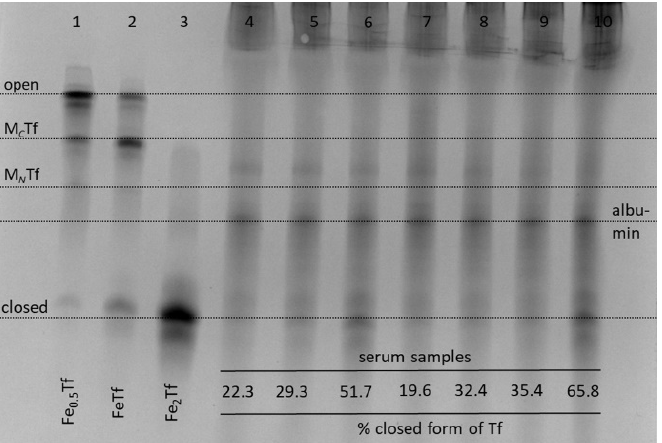
Figure 6. Typical urea-PAGE results for albumin-depleted human serum samples in the presence or absence of metal complexes: lane 4, no metals added; lane 5, Fe(III)-citrate; lane 6, Fe(III)-NTA; lane 7, Cp 2 TiCl 2 ; lane 8, VOSO 4 · 5H 2 O; lane 9, Na 3 VO 4 ; lane 10, In(III)-citrate. Whole serum was incubated with 50 μM of metal complexes for 4 h at 310 K, followed by the removal of excess albumin with Affi-Gel Blue columns (see Materials and Methods). Lanes 1–3 show control Tf samples with various Fe saturation in an aqueous buffer (20 mM HEPES, 25 mM NaHCO 3 , 140 mM NaCl, pH 7.4) [3]. Four main Tf conformations (Figure 1) are marked based on control samples (M C Tf and M N Tf contain one metal ion bound to C -lobes or N -lobes, respectively) and assignment of the albumin band is based on published data [10]. The relative content of closed Tf form in serum samples (shown at the bottom of the gel) was determined by image processing with BioRad ImageLab 5.2 software (Figure S2 in Supplementary Materials).